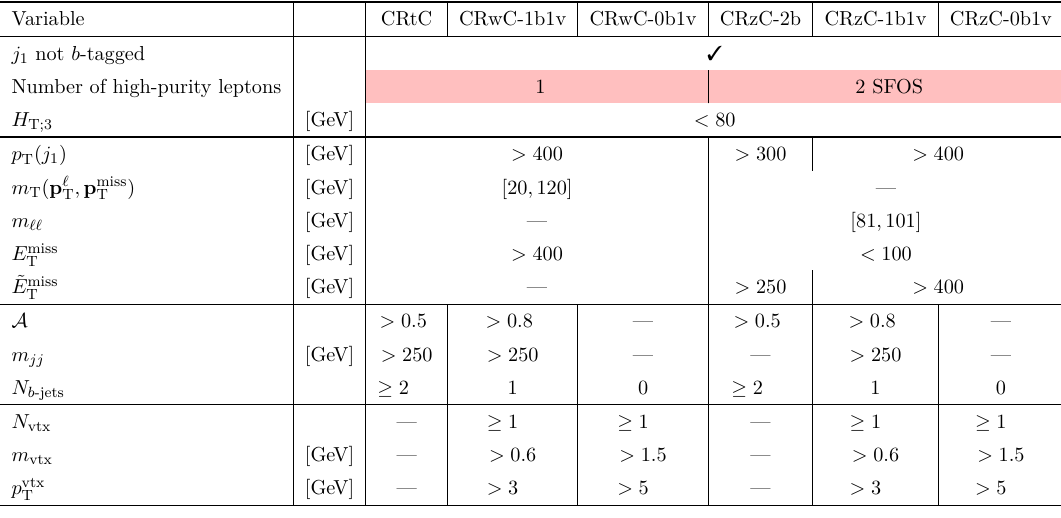
Table 6 . SRC control region definitions. Pink cells for the control regions’ columns indicate which selections ensure that they are orthogonal to the corresponding